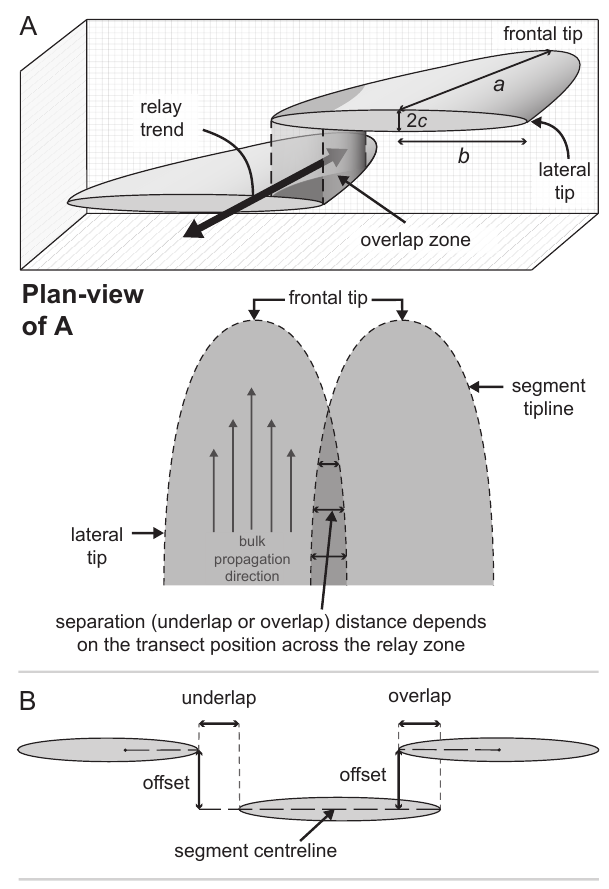
Figure 3: Terminology used here to describe intrusive segments. [A] schematic three-dimensional diagram and plan view below to illustrate segment geometry: thickness ( t “ 2 c ), width ( w “ 2 b ), length ( l “ 2 a ), frontal and lateral tips, and relay zone trend. [B] Terminology describing segment arrangement: separation (underlap or overlap) and